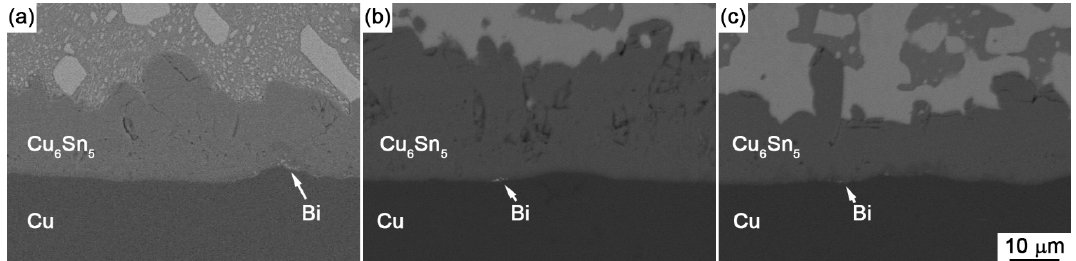
Figure 9. Bi segregation at the interface between Cu 6 Sn 5 and Cu in ( a ) Sn-30Bi; ( b ) Sn-45Bi; and ( c ) Sn-58Bi aged solder joint with a time of 30 days.